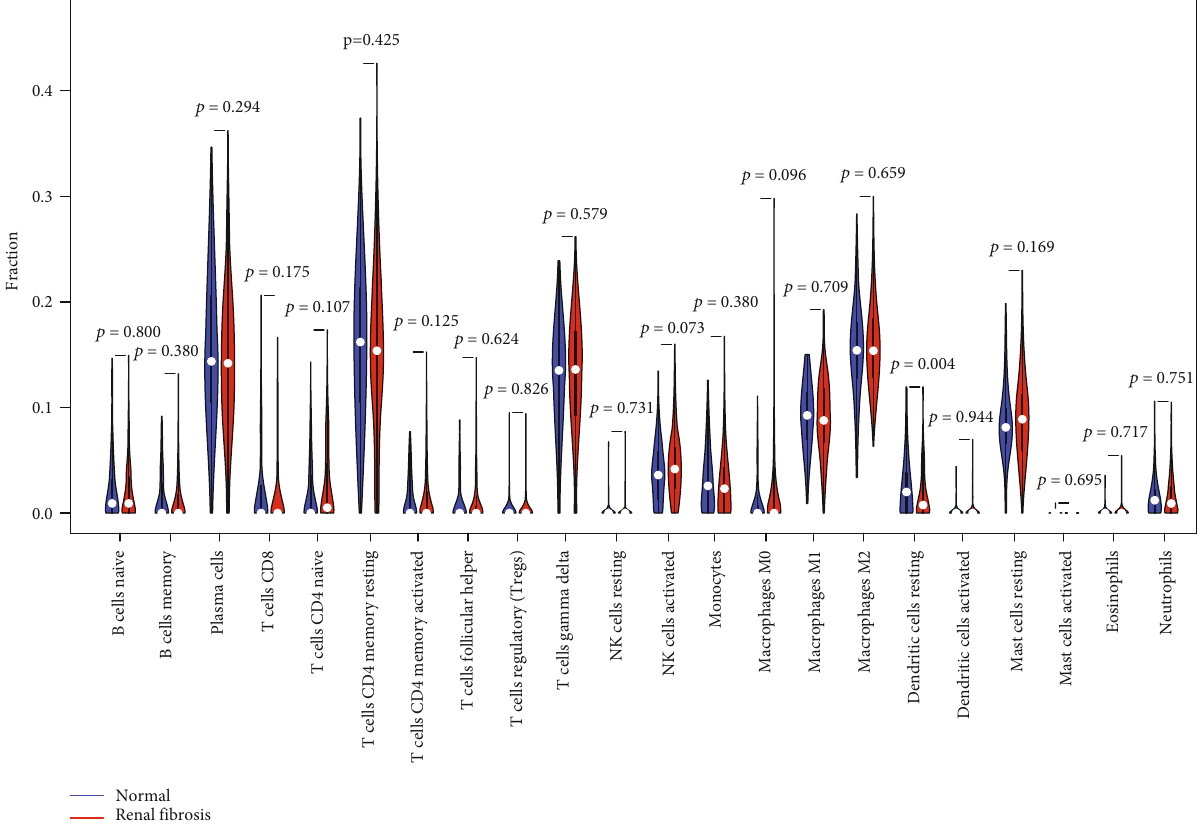
Figure 7: Between renal fi brosis and normal kidney tissues, 22 immune cell subtypes were analyzed and